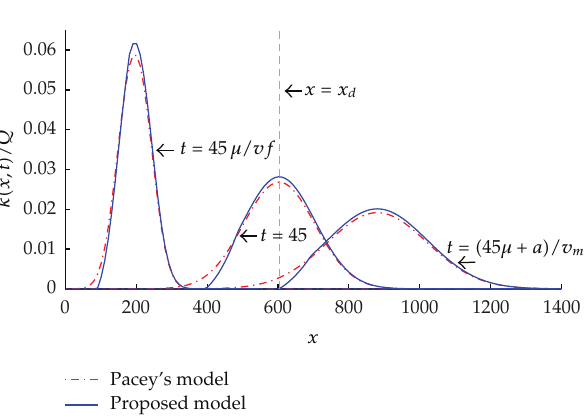
Figure 2: Comparison of the proposed model’s and Pacey’s density distribution function k (cid:6) x,t (cid:7) under x d (cid:8) 45 μ